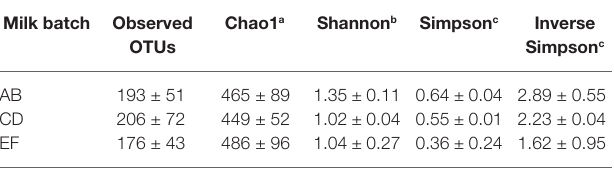
a Chao1 diversity index indicates the microbial richness for the three different batches of unpasteurized milk. b Shannon diversity index indicates the richness and evenness of the microbial community in the three different batches of unpasteurized milk. c Simpson and Inverse Simpson diversity indices indicate the diversity of the microbial community in the three batches of unpasteurized